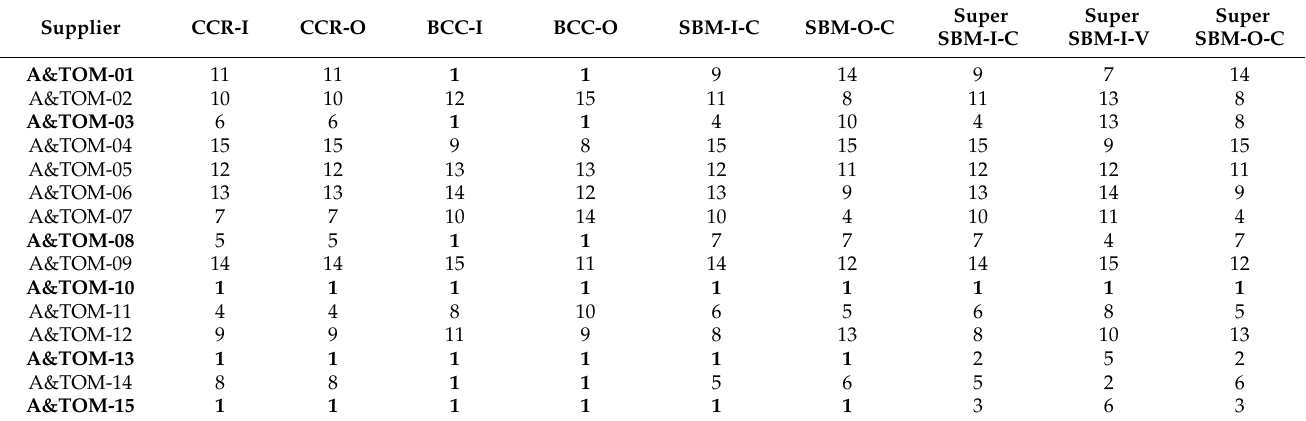
Table 18. A&TOMs ranks with nine DEA models.